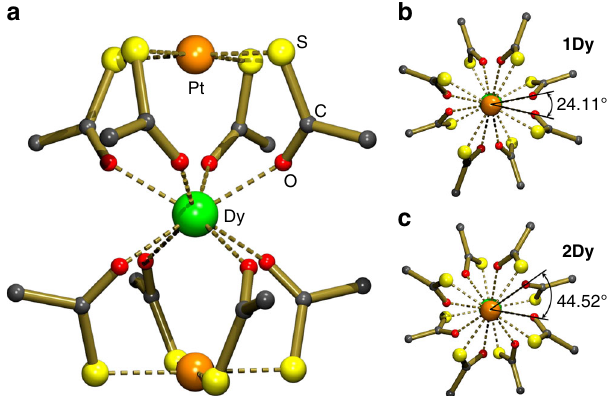
Fig. 1 Molecular structures. Molecular structure of the anionic dysprosium complex in crystals of 2Dy 33 viewed perpendicular to the c axis ( a ). 1Dy 33 ( b ) and 2Dy ( c ) viewed along the fourfold axis ( c axis of the unit cell), with the respective values of the twist angle